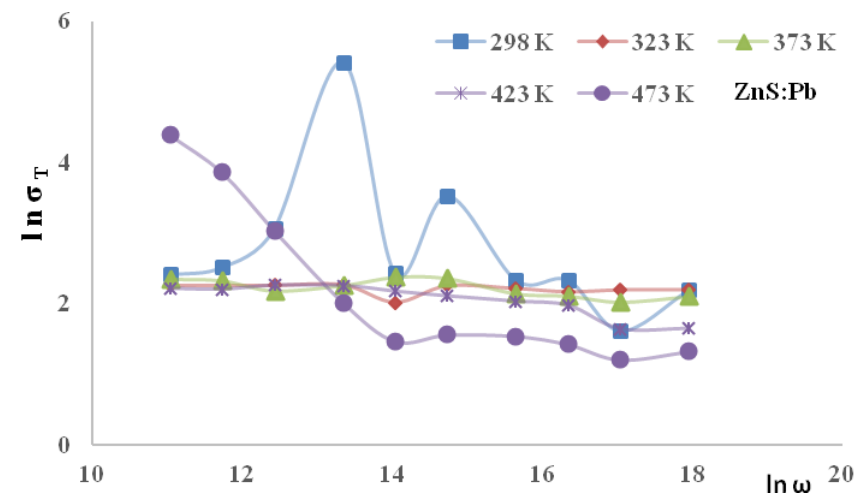
Fig. 3: The variation of ln σ